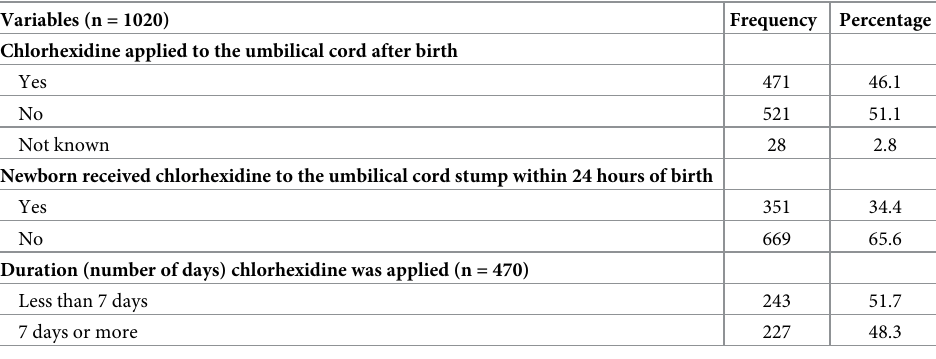
Table 3. Chlorhexidine cord care of neonates, four regions of Ethiopia, Feb 2020. Variables (n = 1020)